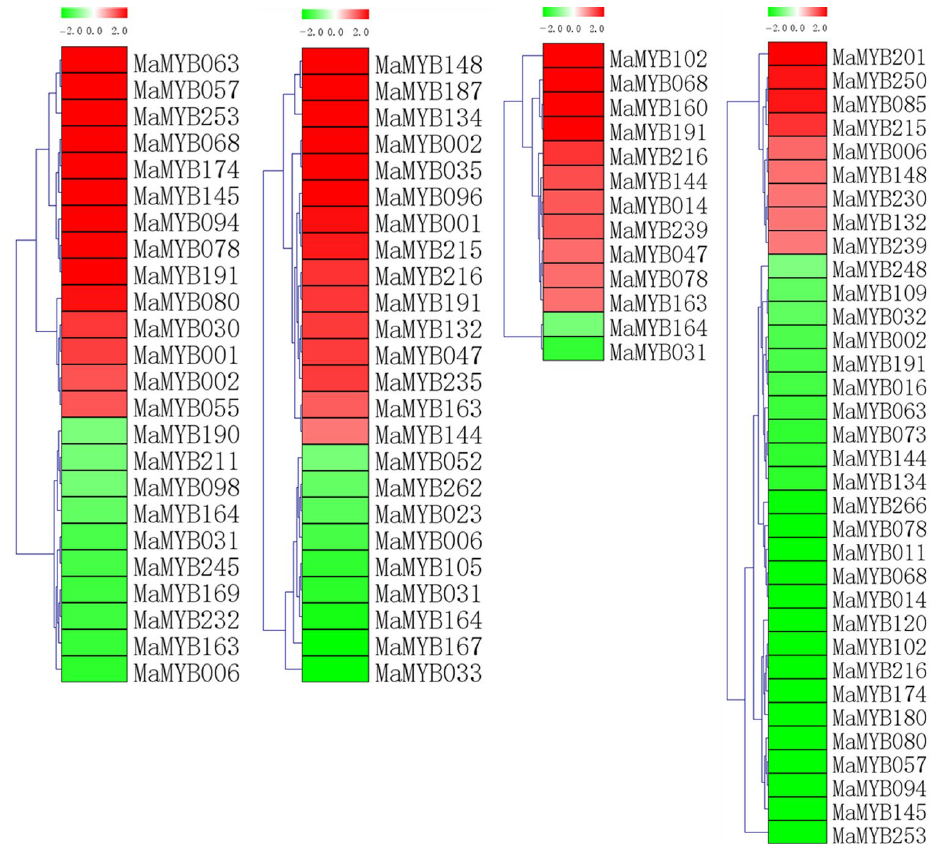
Figure 5. Expression patterns of MaMYBs in response to cold ( a ), osmotic ( b ), and salt ( c ) treatments and inoculation with Foc TR4 ( d ) in banana. A Log2-based fold change was used to create the heatmap. Differences in gene expression changes are shown in color as the scale.